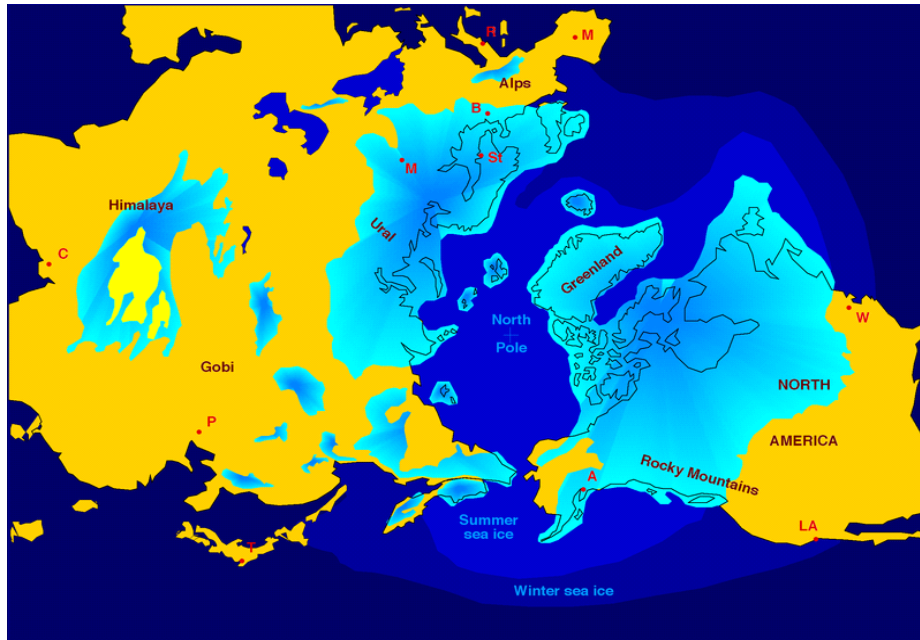
Figure 5. The Last Ice Age, completed 10,000 years ago, precisely at the time of the birth of Lepenski Vir culture Archaeologist’s diary of Obrad Kujović, that time researcher at Archaeological Institute of the Serbian Academy